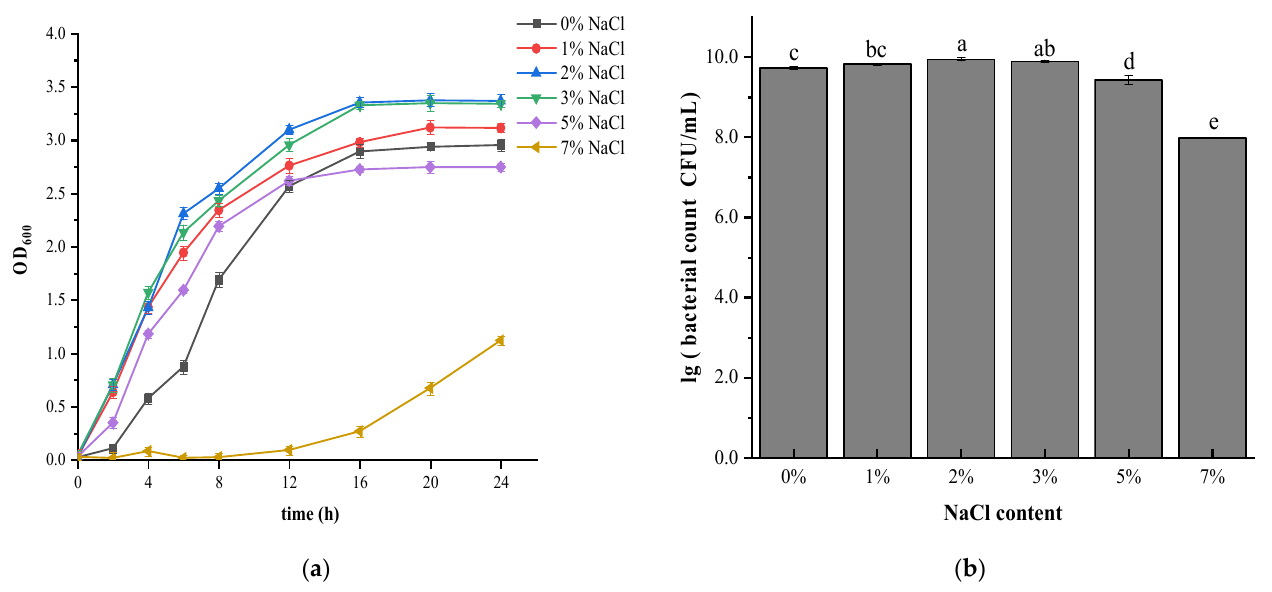
Figure 1. Effect of salt concentration on growth of V. brasiliensis . ( a ) Growth rate of V. brasiliensis incubated in culture medium with different NaCl content. ( b ) Survival ability determination of the V. brasiliensis cultivated in different NaCl content medium. Values are means of three independent experiments. Different lowercase letters denote significant differences ( p < 0.05).